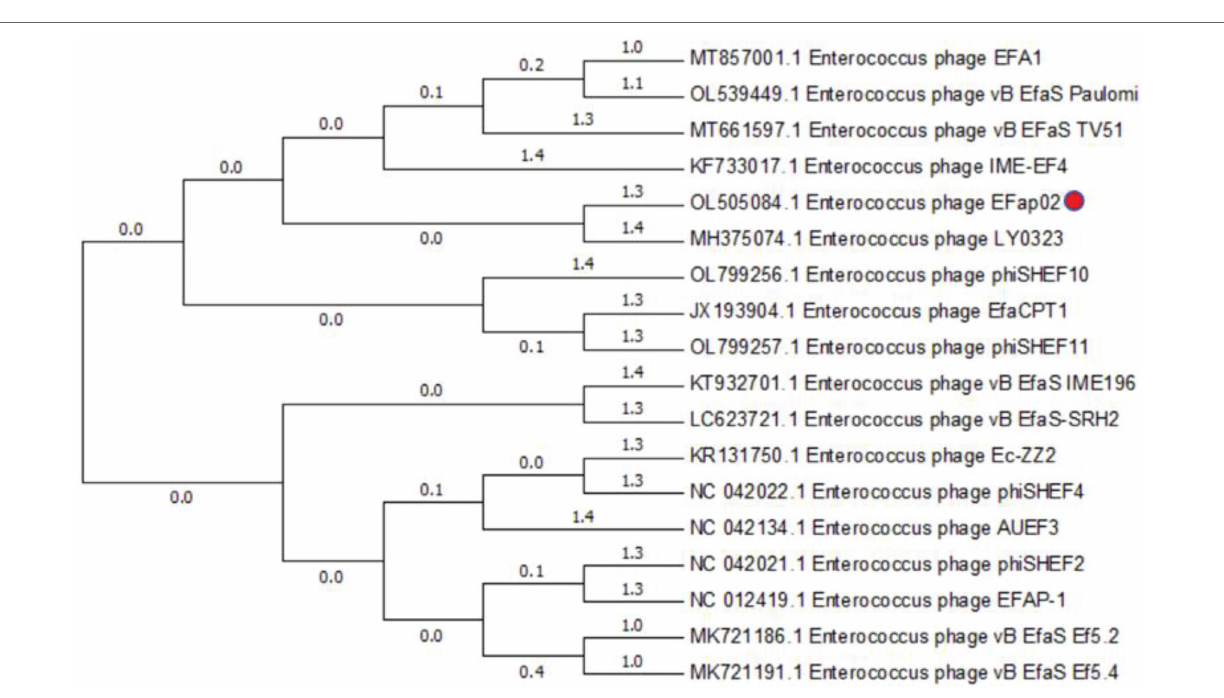
FIGURE 4 | Phylogenetic relationships of phages infecting Enterococcus faecalis . Terminase large subunit and the neighbor-joining method were used to construct the phylogenetic tree.